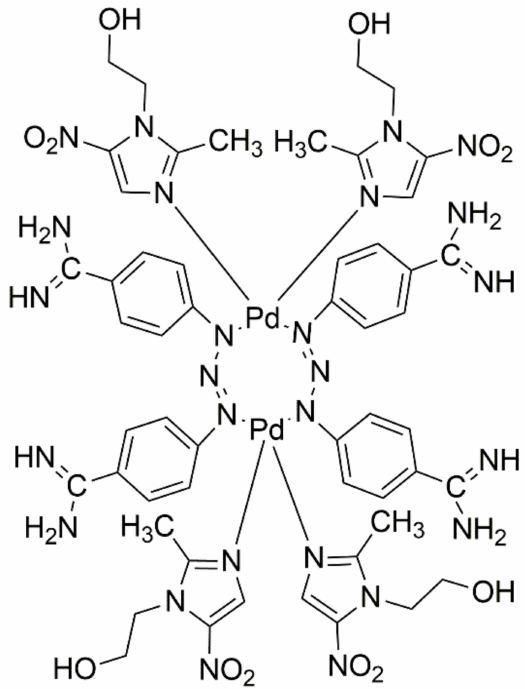
Figure 19. Structure of dinuclear novel palladium (II) complex with